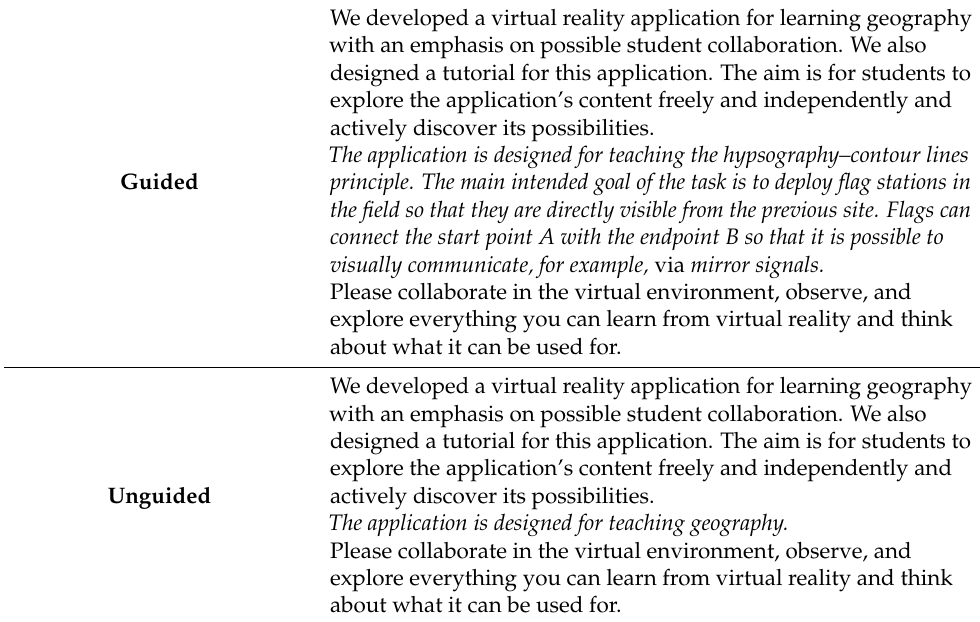
Table 1. Guided and unguided task instructions.